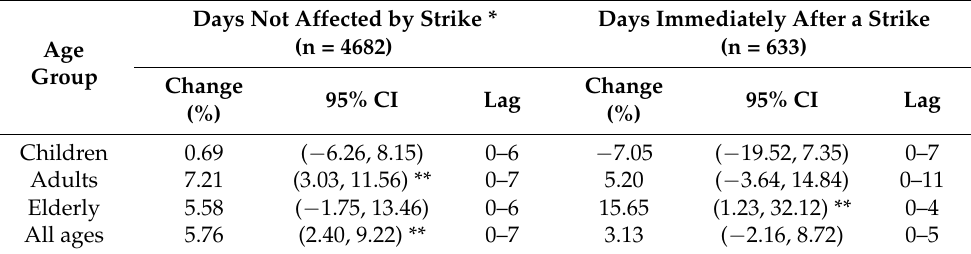
Table 3. Percentage change (95% confidence interval) in the daily number of asthma patients treated with nebulized medication in relation to a 1 ◦ C decrease in mean temperature by the different periods affected or not affected by